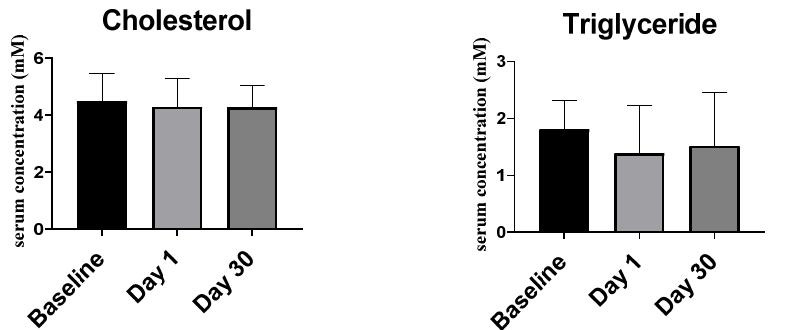
Figure 2. Serum cholesterol and triglyceride concentrations. The mean serum cholesterol and triglyceride concentrations at baseline, day 1 and day 30 are displayed. The error bars represent standard error of mean (SEM) and interquartile range, respectively. Data were analyzed by one- way (ANOVA) followed by Tukey’s multiple comparison and by non-parametric repeated measure ANOVA followed by Wilcoxon signed-rank multiple comparison test, respectively.